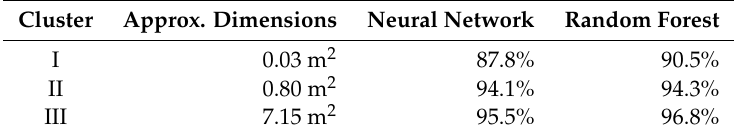
Table 3. Correct assignments using an artificial neural network and a random